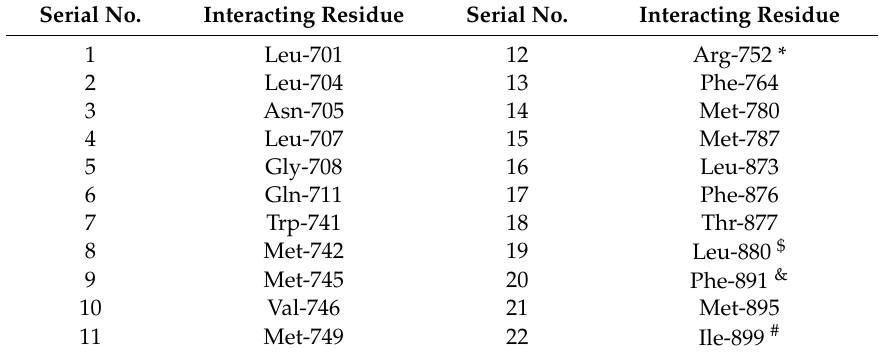
Figure 6. Ribbon diagram representing the docking pose of human androgen receptor (AR) with mono-(2-ethyl-5-carboxypentyl)phthalate (5-cx-MEPP) (left panel). The interactions of ligand (5-cx- MEPP) with amino-acid residues in the binding pocket of AR (right panel). Table 3. Interacting amino-acid residues in the binding pocket of human androgen receptor that were common among natural ligand, testosterone, and di(2-ethylhexyl) phthalate (DEHP)